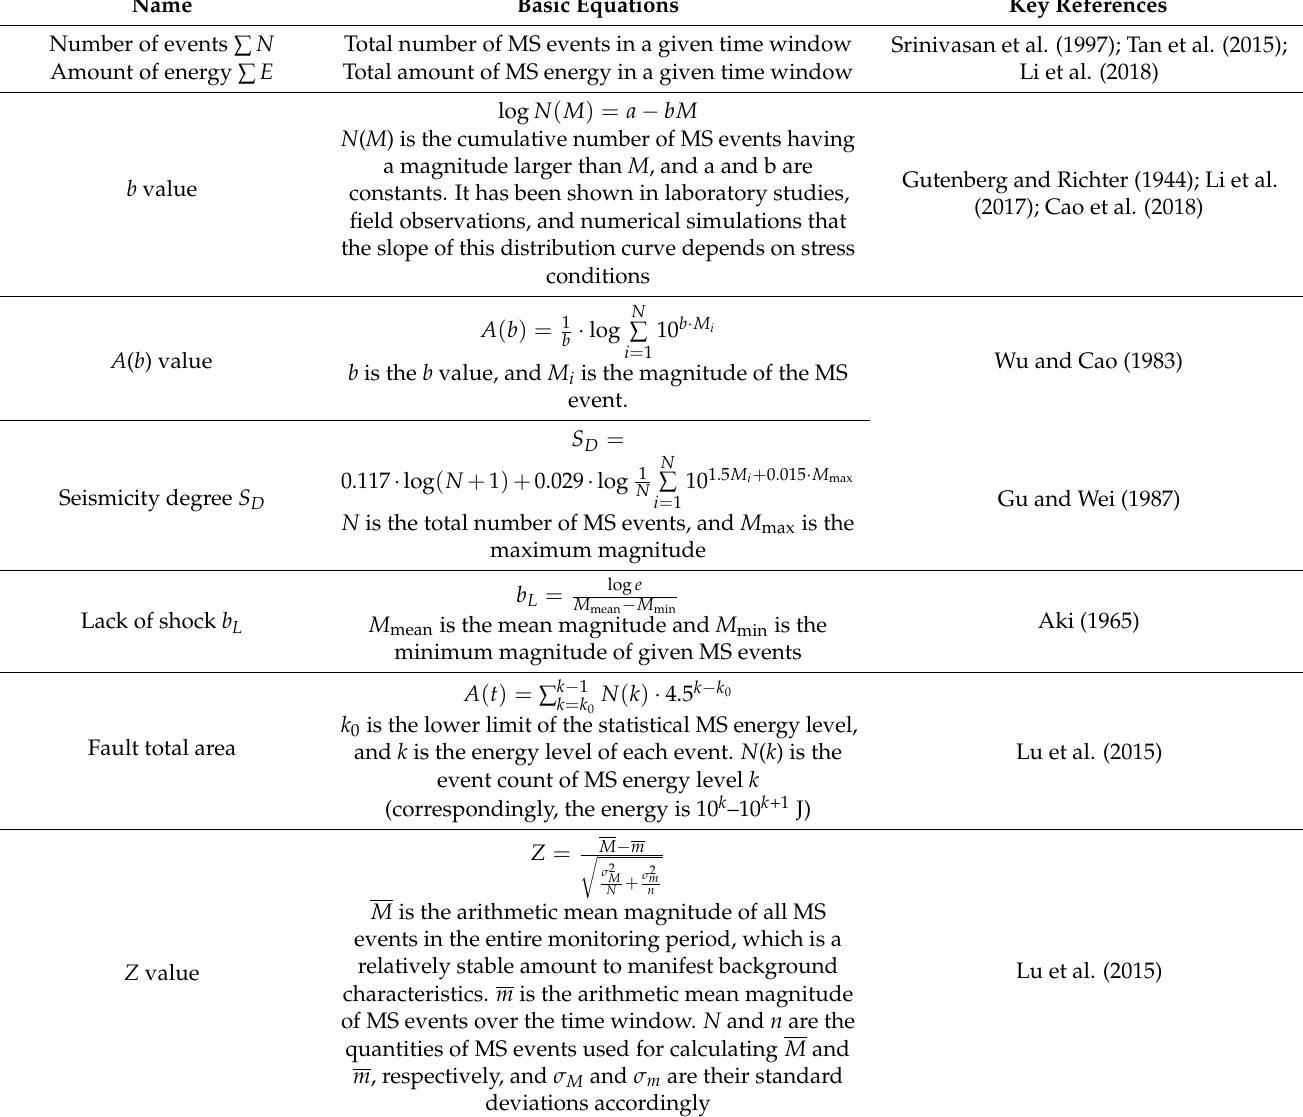
Table 1. Microseismic (MS) indicators for early warning of rockburst